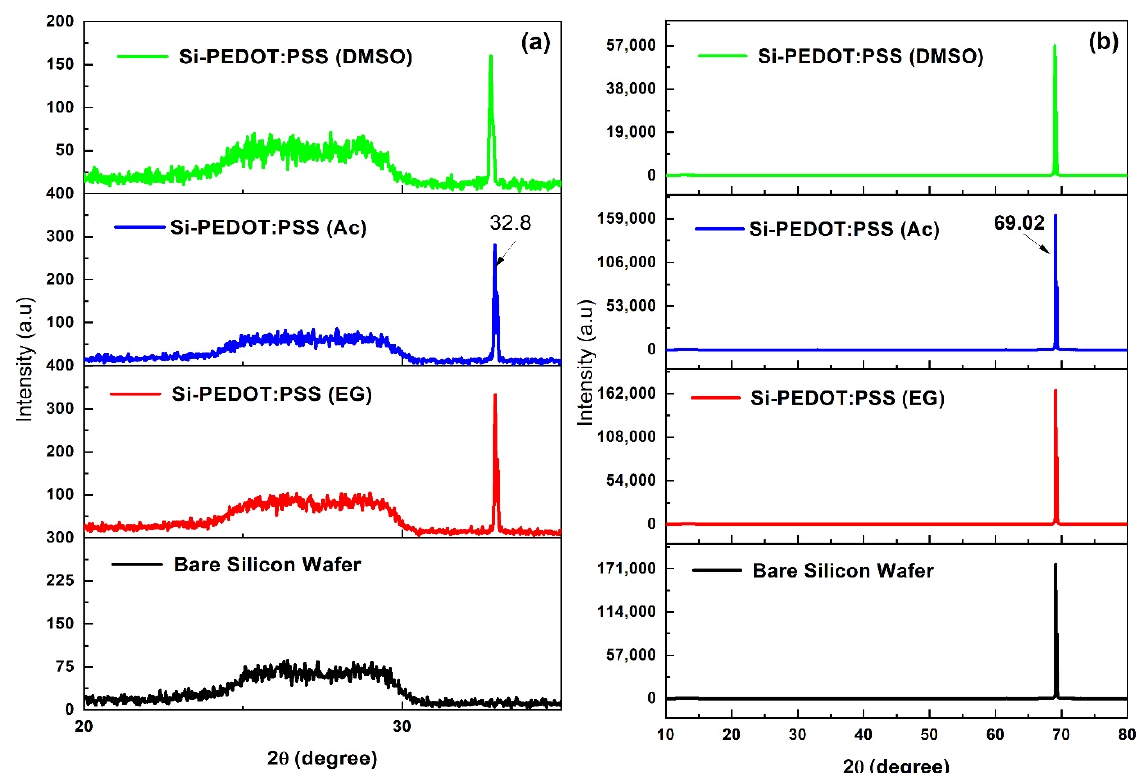
Figure 5. Powder X-ray diffraction of ( a ) SiO 2 and Si/PEDOT: PSS; ( b ) Si peak for all the samples. Table 2. d-spacing and 2 θ value calculated from XRD data Wafer d-Spacing (Å) 2 θ (degree) Si-PEDOT: PSS (EG)